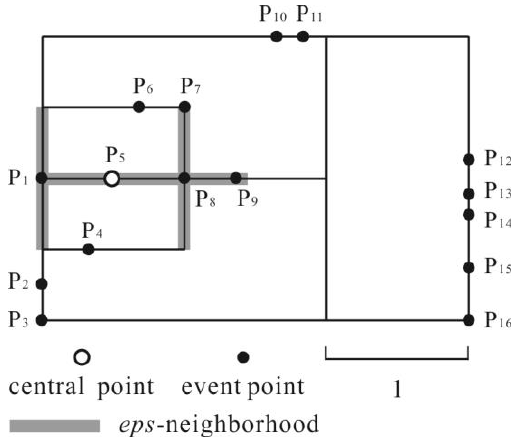
Figure 1. A simulated dataset including road network and event points. The 1-neighborhood of central point P 5 is marked as a thick gray line, covering four event points (P 1 , P 7 , P 8 , and P 9 ).